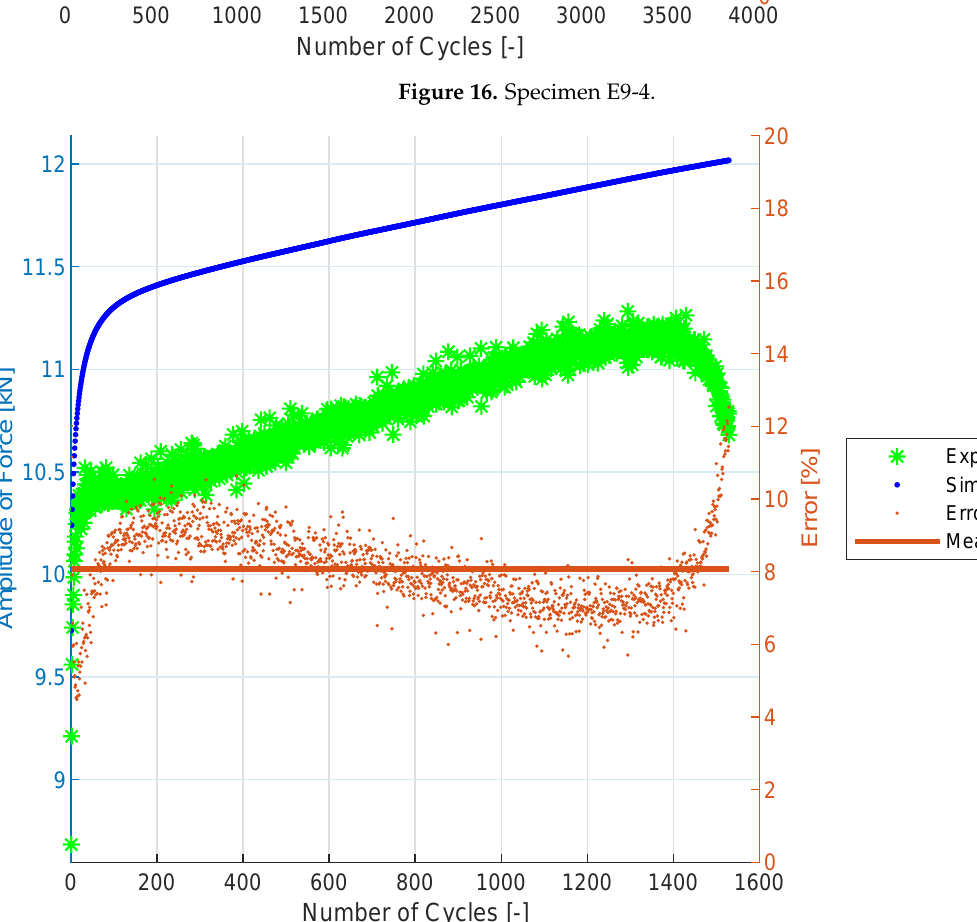
Figure 16. Specimen E9-4.